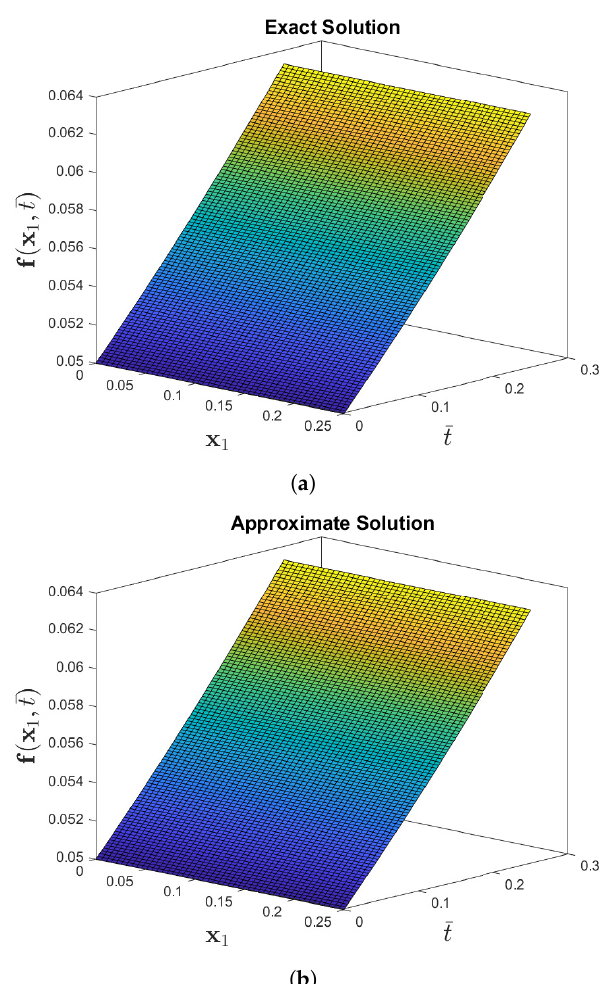
Figure 1. Numerical behavior of exact and approximate solution to the f ( x 1 , ¯ t ) for Problem 1 when the parameters are η = 0.05, θ = 1, β = 1, and ϕ =